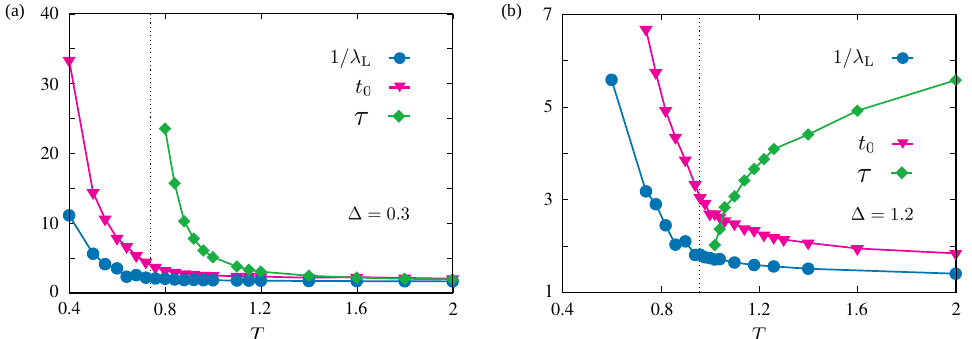
Figure 4: Comparison of chaos and relaxation time scales: The T dependence of the delay time t , Lyapunov time λ − 1 and the relaxation time τ , extracted from spin 0 L ( t ) above the transitions, are shown for (a) easy-plane auto-correlation function C x y ( ∆ = 0.3) and (b) easy-axis ( ∆ = 1.2) anisotropies. Vertical dotted lines denote the